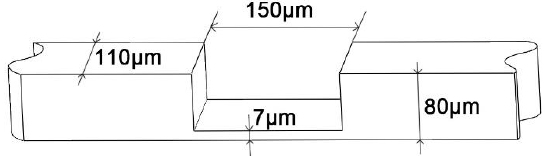
Figure 1. The thin-walled structure of the component.